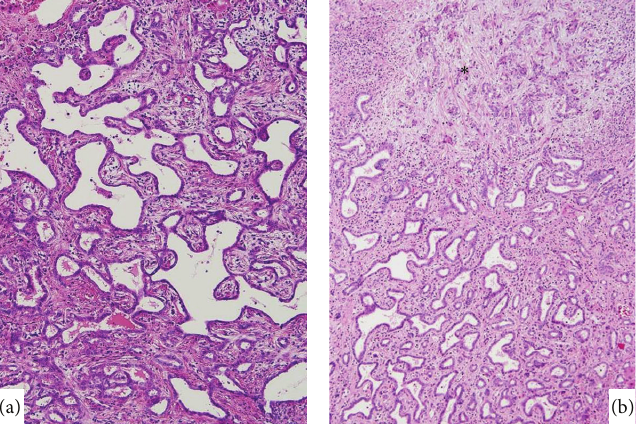
Figure6:(a)Intrahepaticcholangiocarcinomawithfeaturesofductalplatemalformation.Theyappeartobebluntandlackaggressivefeatures (low grade malignancy). (b) Within this type of cholangiocarcinoma (lower half), there are foci of ordinary cholangiocarcinoma ( ∗ ).